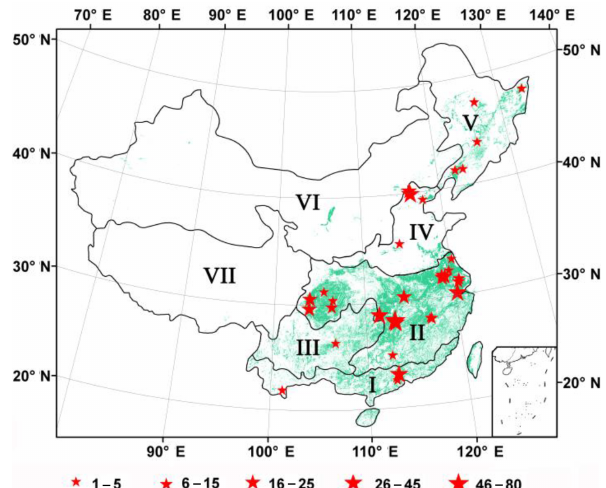
Figure 1. Locations of the experimental sites (red stars). The back- ground map represents the spatial distribution of rice paddies in China. The size of the red stars is proportional to the number of measured methane fluxes at the site. The polygons show zones of different crop rotation systems involving rice: I – double rice rota- tion, II – mixed zone of rice and rice rotation and rice and upland crop rotation, III & IV – rice and upland crop rotation or rice and fallow rotation, V & VI – rice and fallow rotation, and VII – no